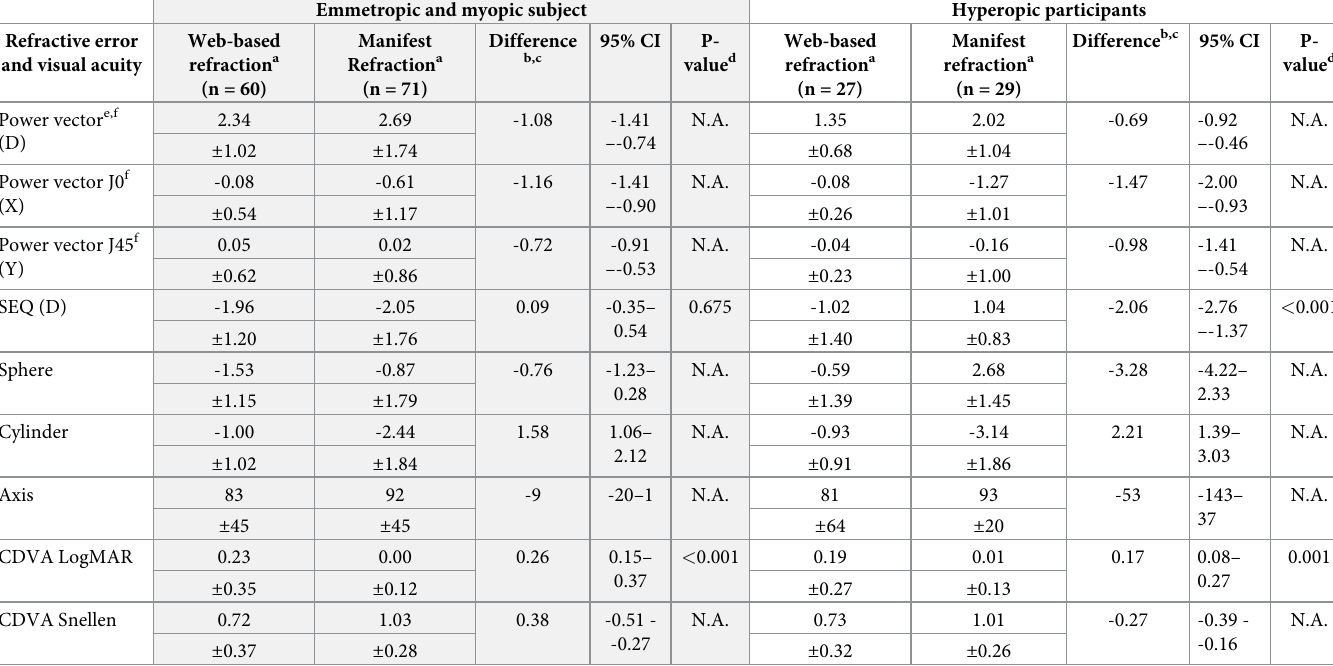
Table 2. Measured refractive error and visual